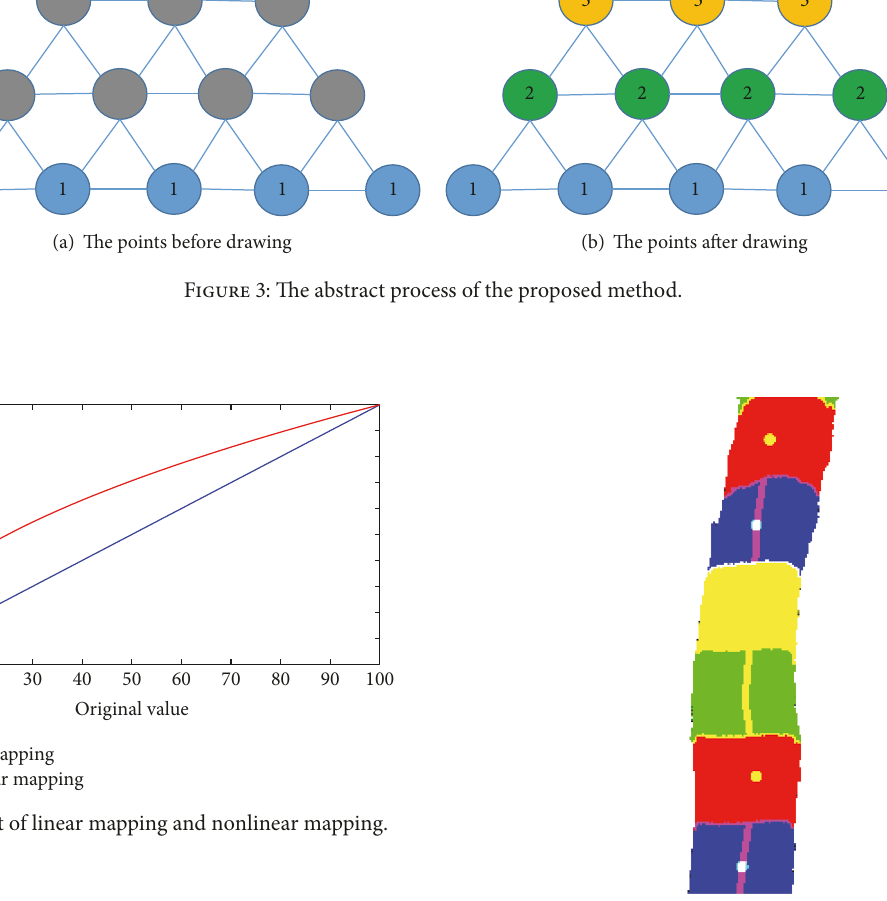
Figure 6: The demonstration of connecting